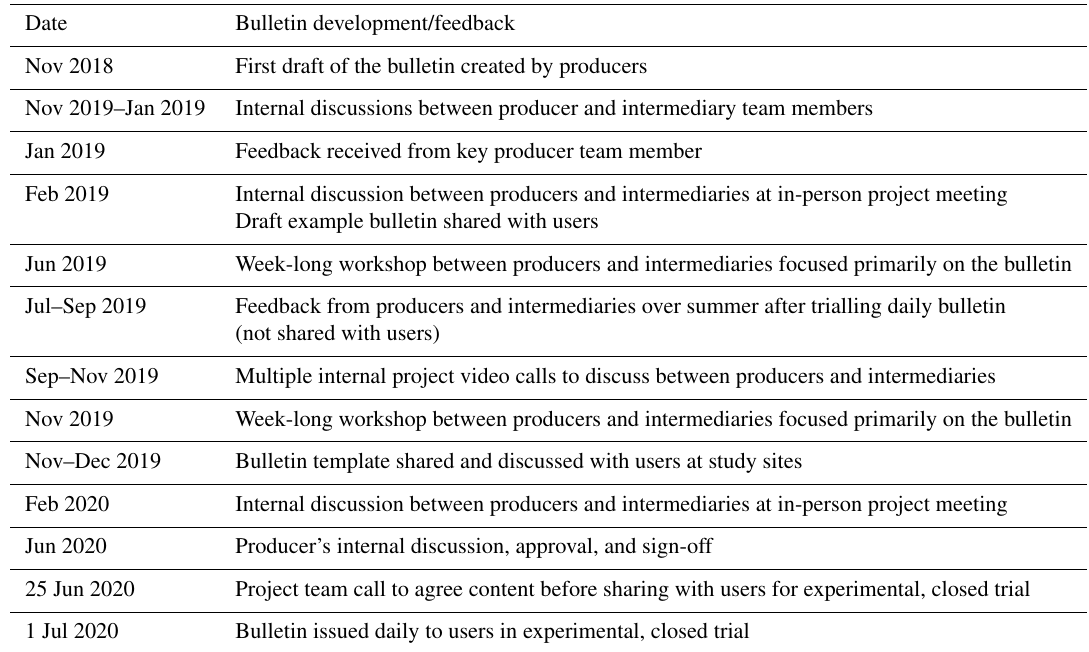
Table 1. Timeline and sources of feedback for the landslide bulletin